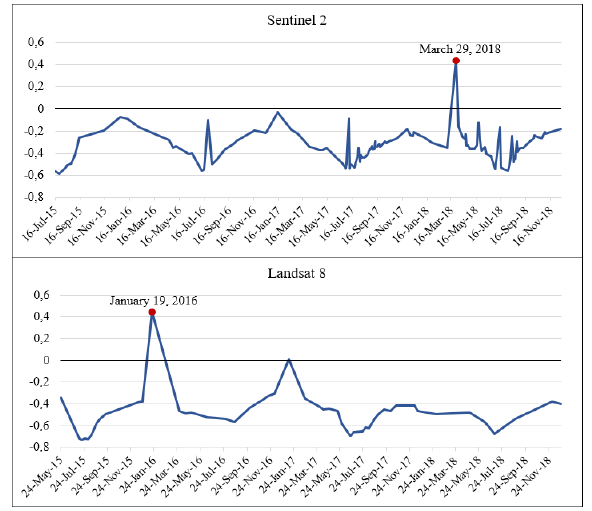
Figure 5. NDWI time series of the optical images